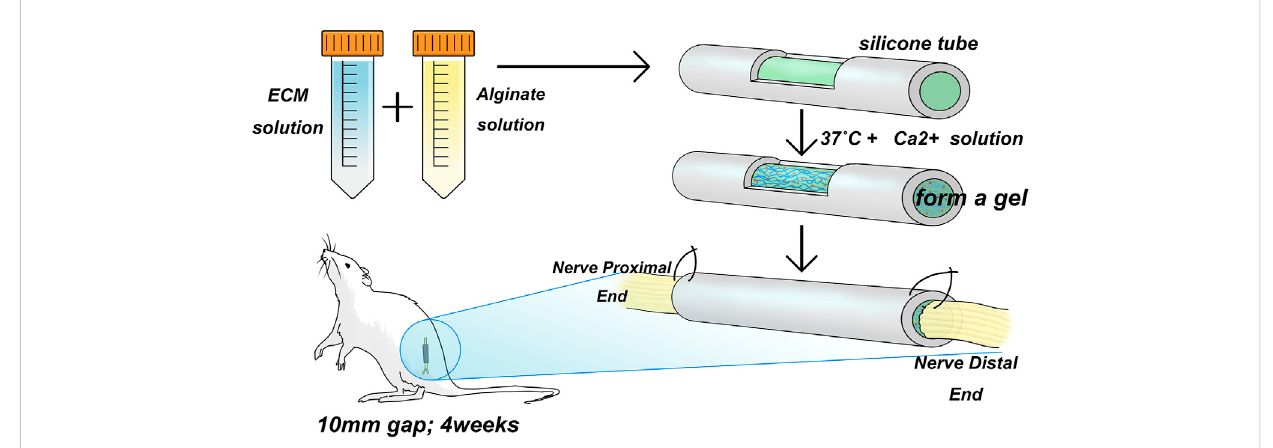
FIGURE 1 Animal modeling diagram. The ECM solution and alginate hydrogel were mixed and introduced into a silicone tube, followed by the addition of a Ca 2+ salt solution at 37 ° C to form a gel. The tube was then used to bridge a 1 mm sciatic nerve gap in adult SD rats by